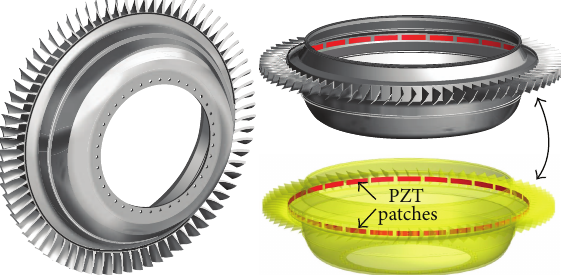
Figure 8: Bladed drum used in this study. Layout of the PZT patches on the inner side of the blade support rim.